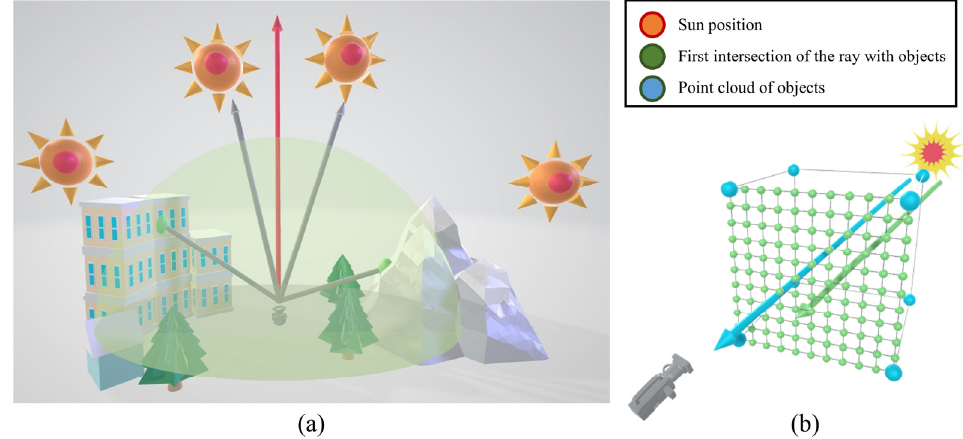
Figure 6. Application principle of ray casting for viewshed analysis. ( a ) Determination of whether sunlight is blocked, and ( b ) application to mesh.